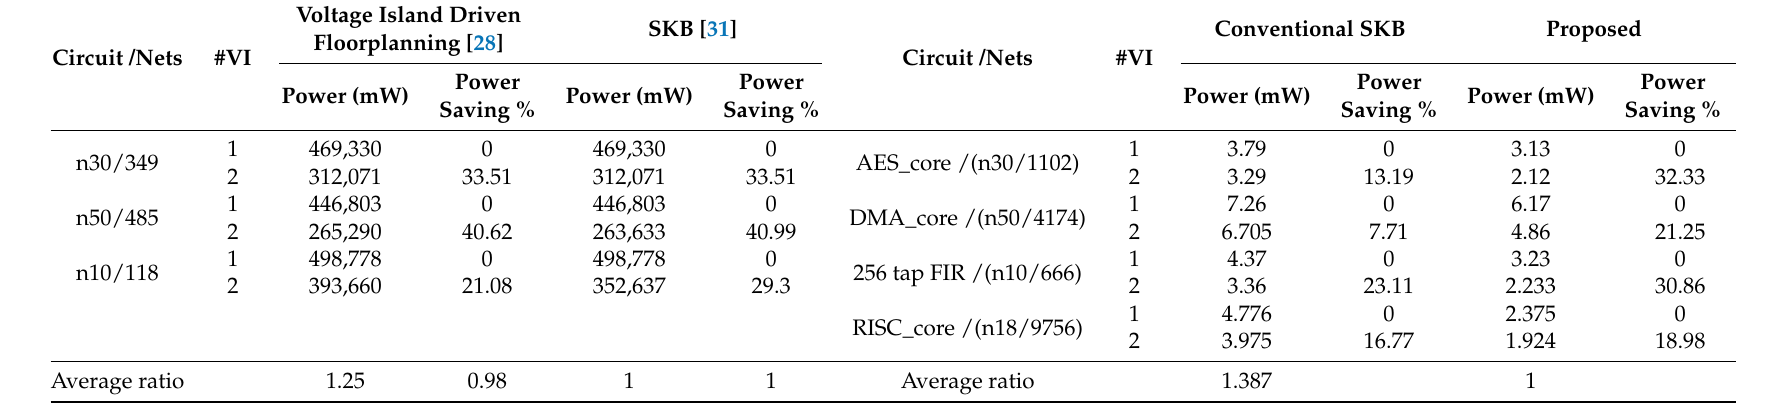
Table 5. Comparisons with previous works for Voltage island